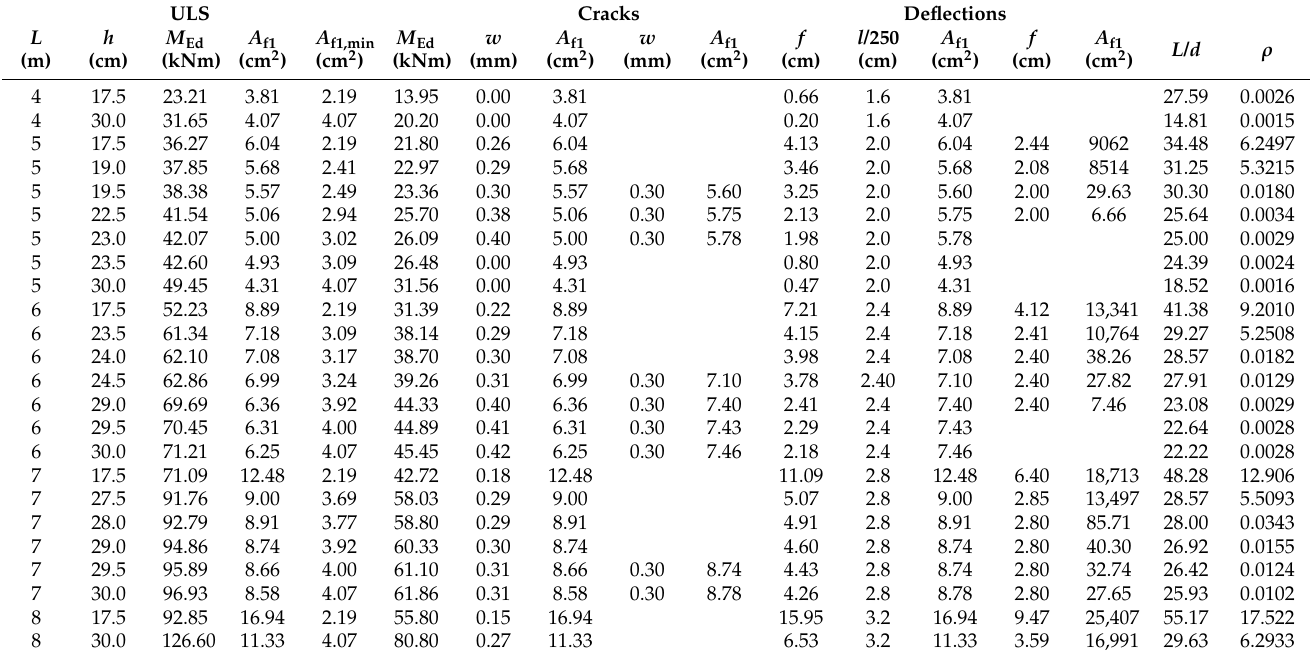
Table 7. Results of parametric analysis for steel-reinforced